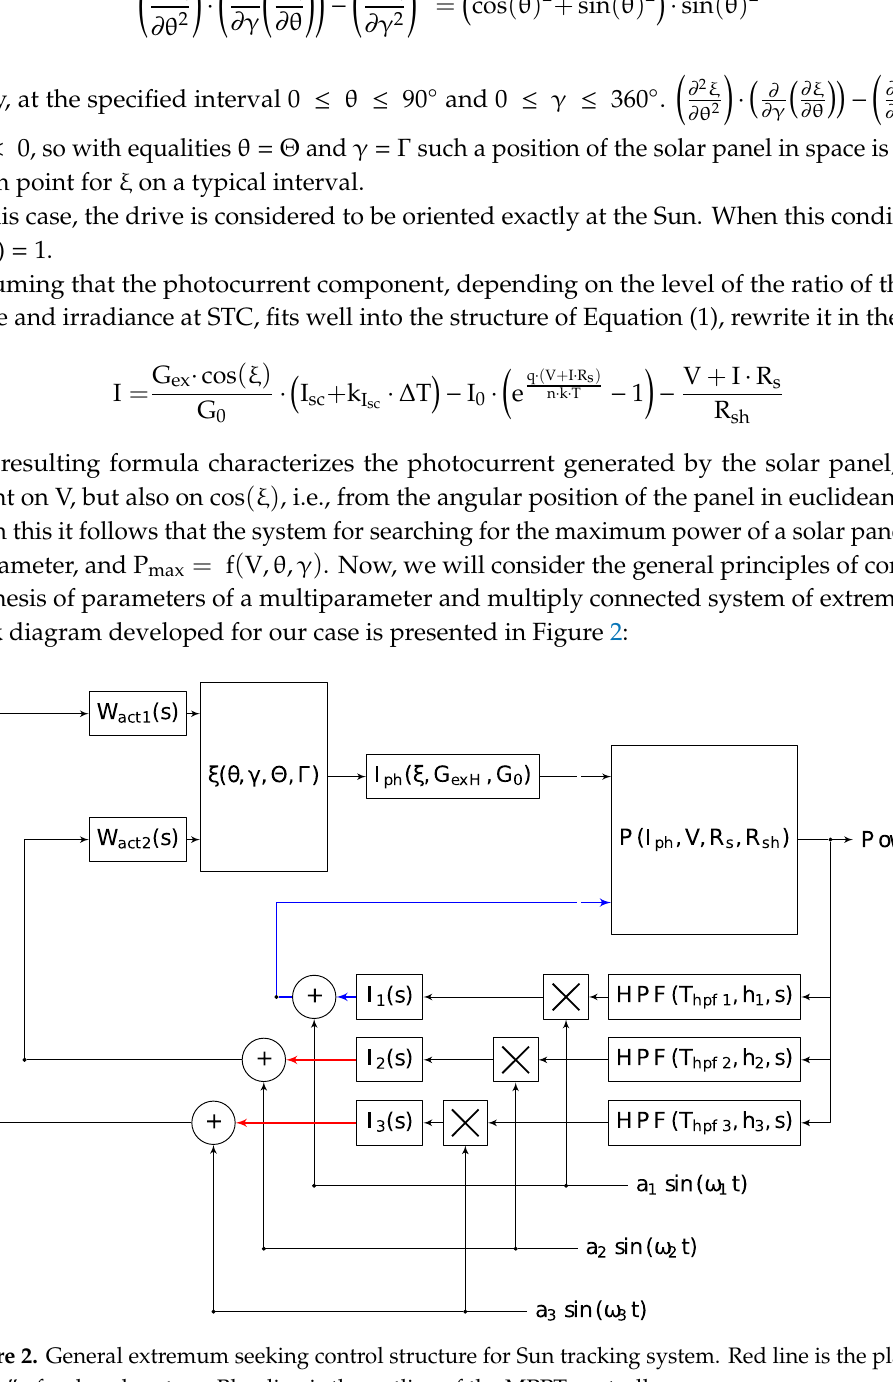
Figure 2. General extremum seeking control structure for Sun tracking system. Red line is the place of “open” of a closed system. Blue line is the outline of the MPPT